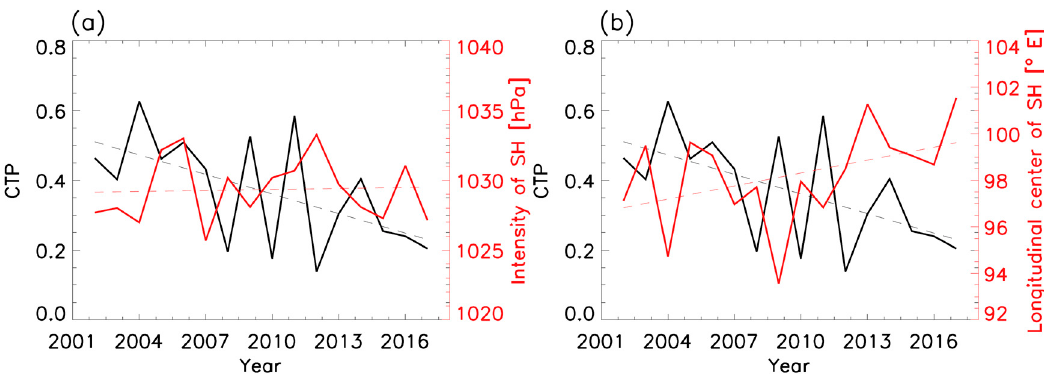
Figure 7. Time series of the ( a ) intensity (left panel) and ( b ) longitudinal center (right panel) of Siberian High against the CTP for 2002–2017. The red lines indicate the intensity and longitudinal center of the Siberian High, and the black line shows the CTP. The units of the intensity and longitudinal center of the Siberian High are hPa and °E, respectively.